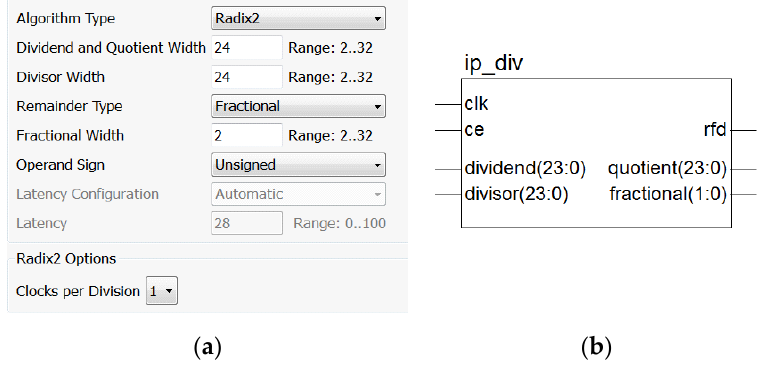
Figure 13. Operation diagram of the divider: ( a ) divider module configuration diagram and ( b ) divider module interface diagram.